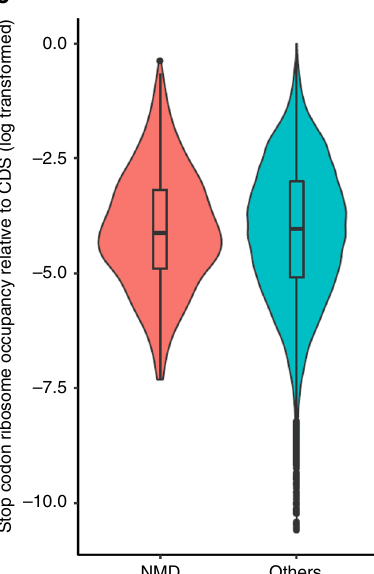
control of the system and its modulation (e.g. introducing nucleotide analogs or mutant versions of translation factors). On the other side, translation factor concentrations are far from physiological conditions and there is a requirement of inter- mediate puri fi cation steps of ribosome complexes, which limits the biological relevance of reconstituted translation